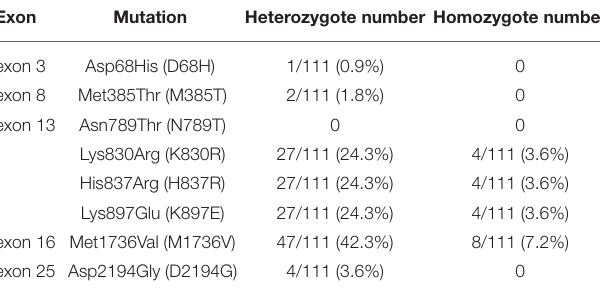
TABLE 2 | Factor V polymorphism distribution for Keelung non-FV deficiency population, including 25 exons. Exon